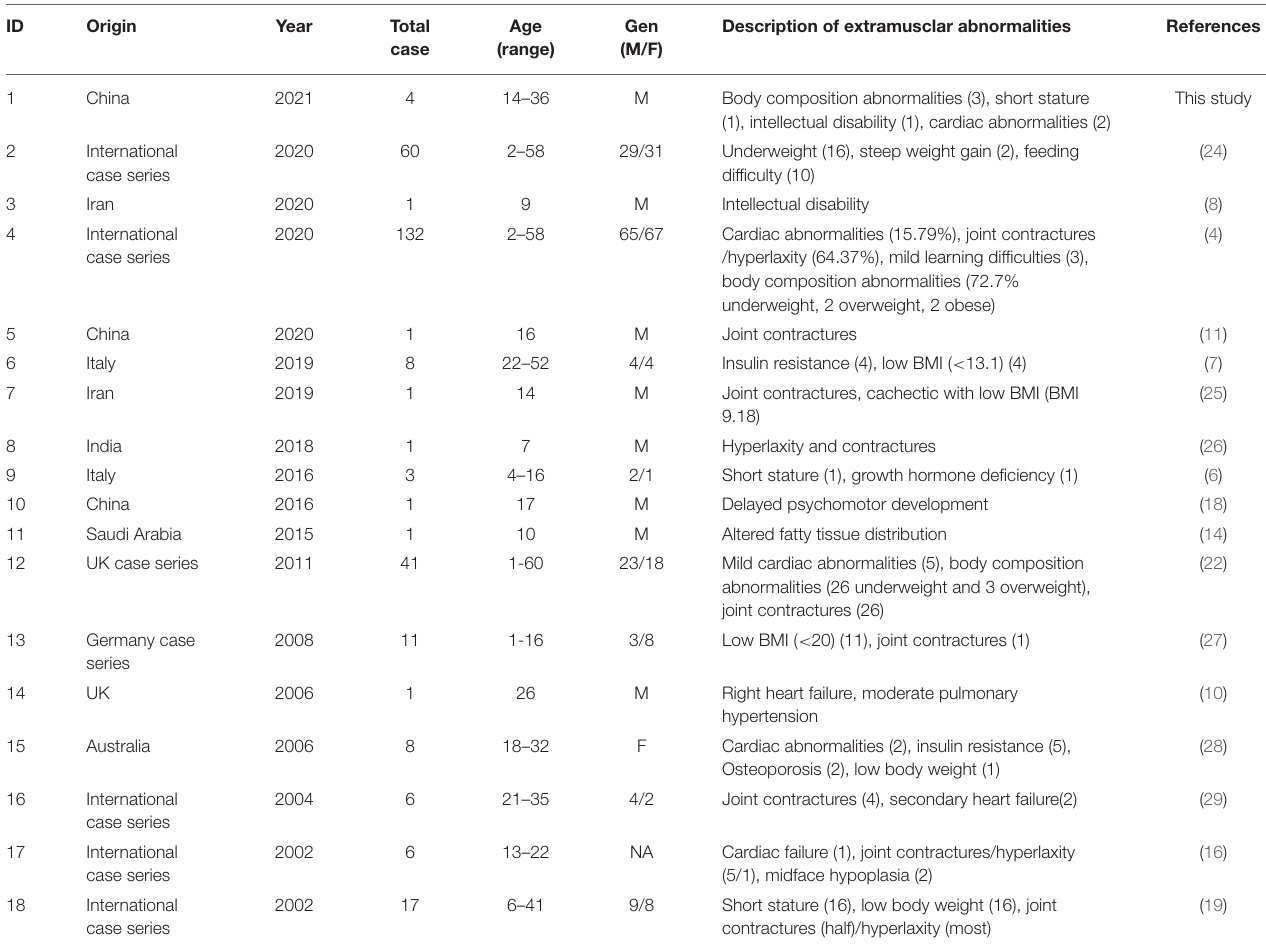
TABLE 4 | Clinical data of the reported SEPN1-RN in patients mentioned extramuscular abnormalities.